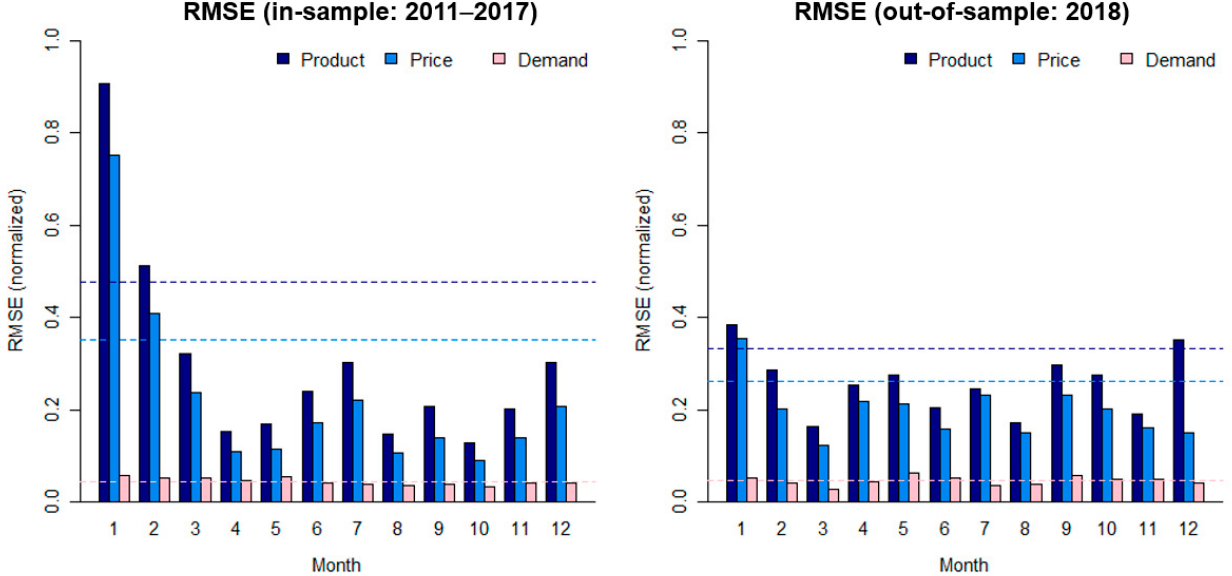
Figure A2. Monthly RMSE for each hedging target.